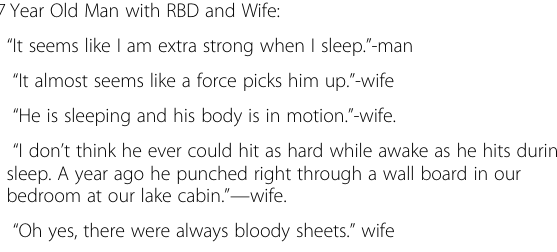
Table 2 Sample dialogues of men with rbd and their wives a 57 Year Old Man with RBD and